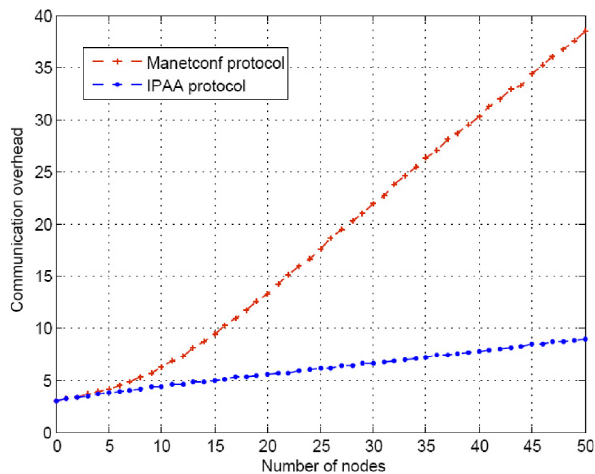
Figure 7. Communication overhead of the IPAA and MANET- conf protocols as a function of network size.